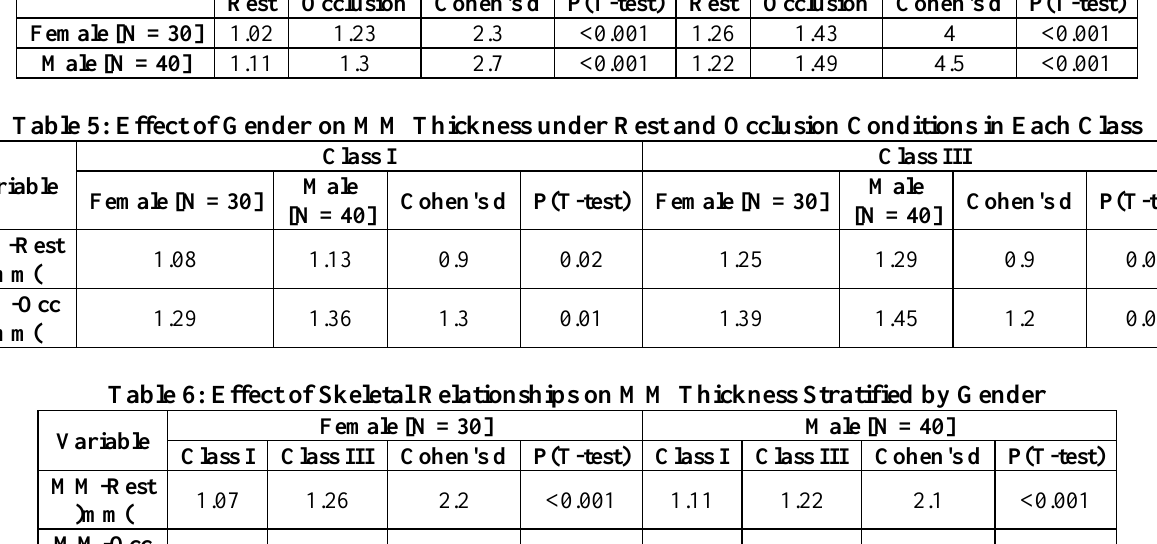
Table 4: Effect of Occlusion Compared to Rest Stratified by Gender and Class Gender